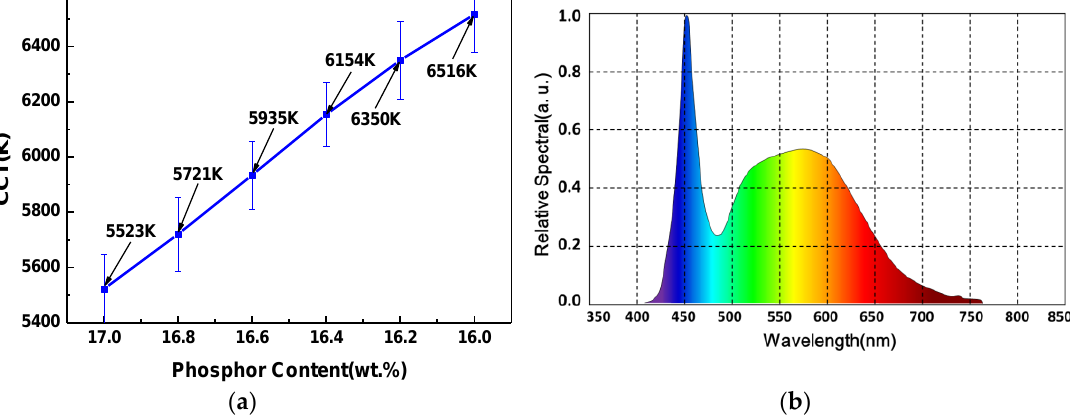
Figure 4. ( a ) Dependence of CCT on the phosphor content for the remote phosphor white LEDs with the TiO 2 diffuser content of 0.2 wt.% in the phosphor layer, ( b ) Electroluminescence spectra of the TiO 2 diffuser-loaded encapsulation remote phosphor LED at a driving current of 350 mA.